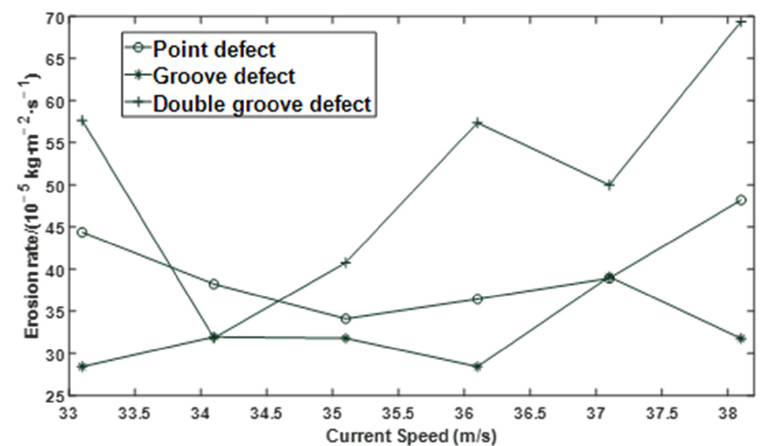
Figure 6. Effect of particle size on erosion rate under different defect conditions.